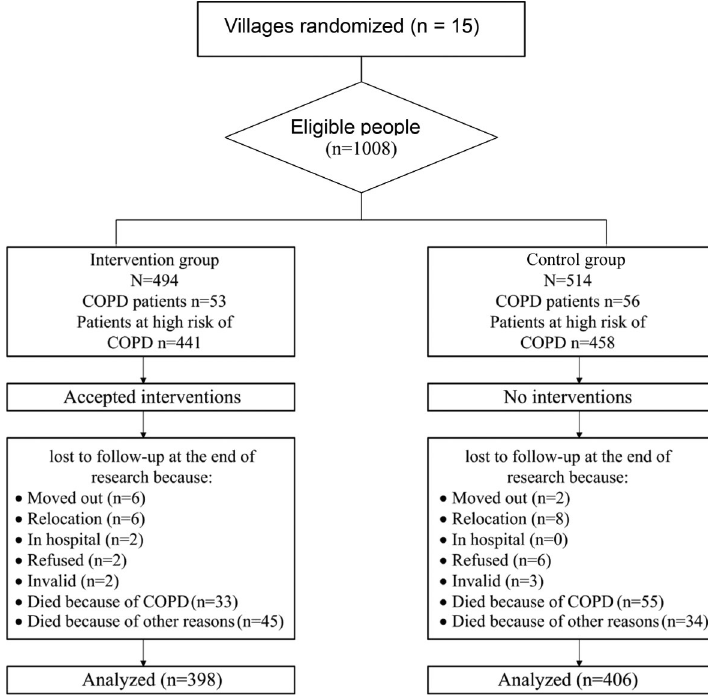
Figure 1. Flow chart of participants in the